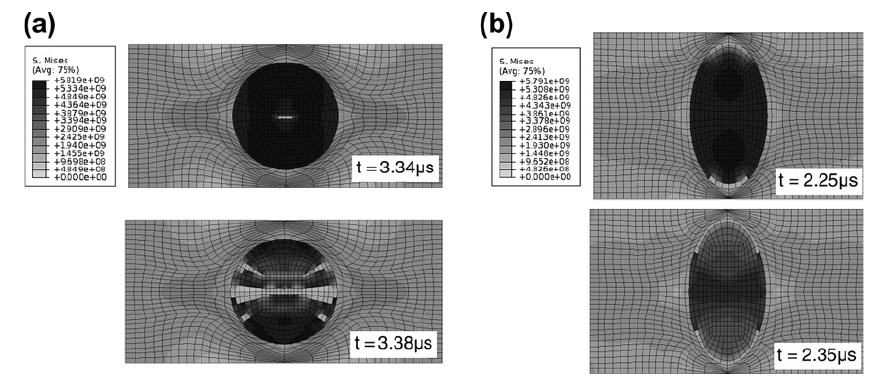
Figure 17. Contour plots of the von Mises stress at different times: ( a ) cracking in the middle of the fiber and ( b ) failure at the fiber–matrix interface [56].